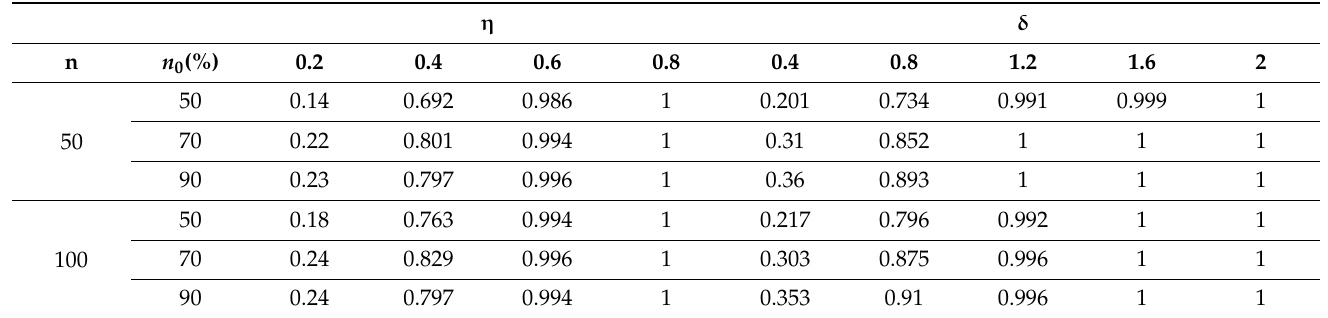
Table 7. Results of power estimates (1-Type II error) for variation in shape ( η ) and magnitude ( δ ) for the case of inter-curve dependence ( ρ = 0.7), considering θ =